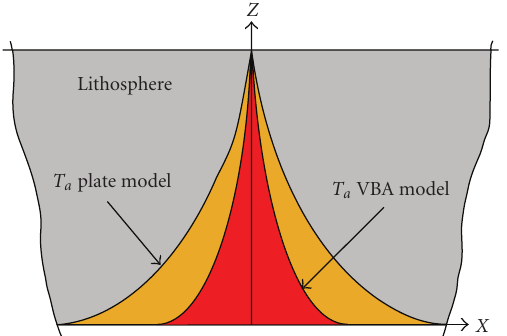
Figure 1: Schematic illustration of solidification isotherms ( T S ) for cases of constant and variable temperature asthenospheric upwelling. Note that the magma injection zone, whose geometry is determined by the depth to the solidification isotherm, is wider for constant temperature case relative to that for variable